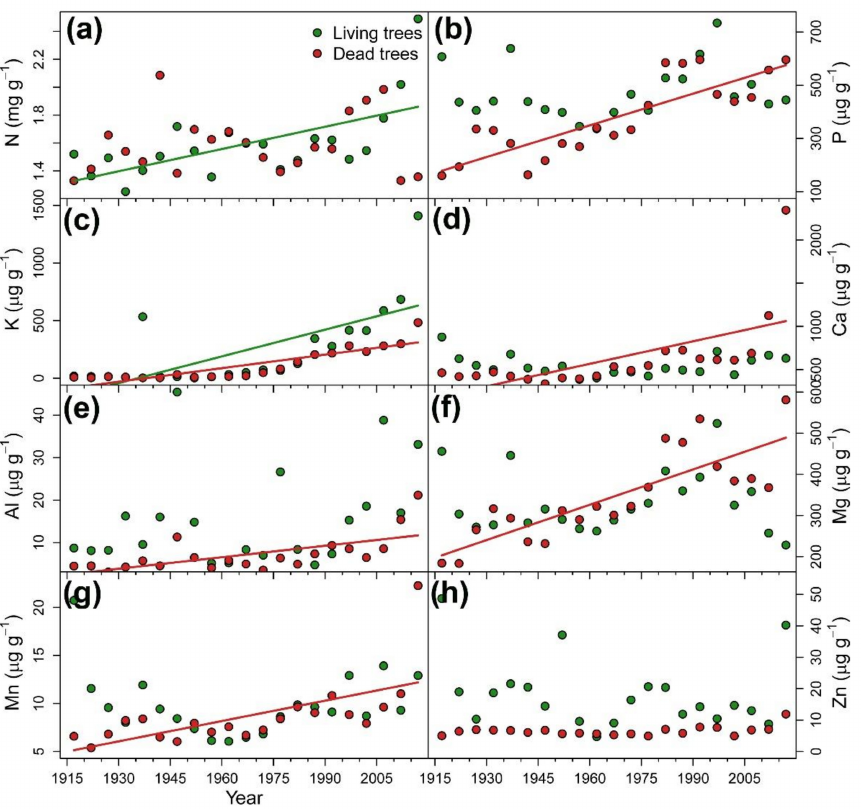
Figure 5. Temporal evolution of nutrient concentration in tree-rings of living (green symbols and lines) and dead (red symbols and lines) Nothofagus dombeyi trees including: ( a ) nitrogen (N), ( b ) phosphorus (P), ( c ) potassium (K), ( d ) calcium (Ca), ( e ) aluminum (Al), ( f ) magnesium (Mg), ( g ) manganese (Mn), and ( h ) zinc (Zn). Symbols represent values of five consecutive rings pooled at vigor class level and lines indicate significant trends based on the Kendall τ statistic (see Table